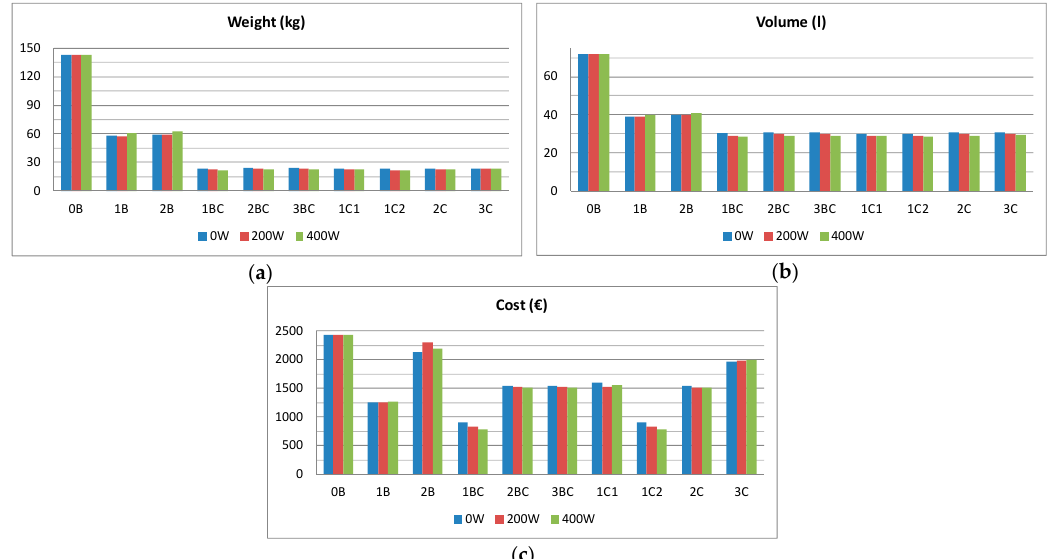
Figure 6. Influence of the fuel cell minimum power the power distribution system (PDS): ( a ) Mass, ( b ) Volume. ( c ) Cost.